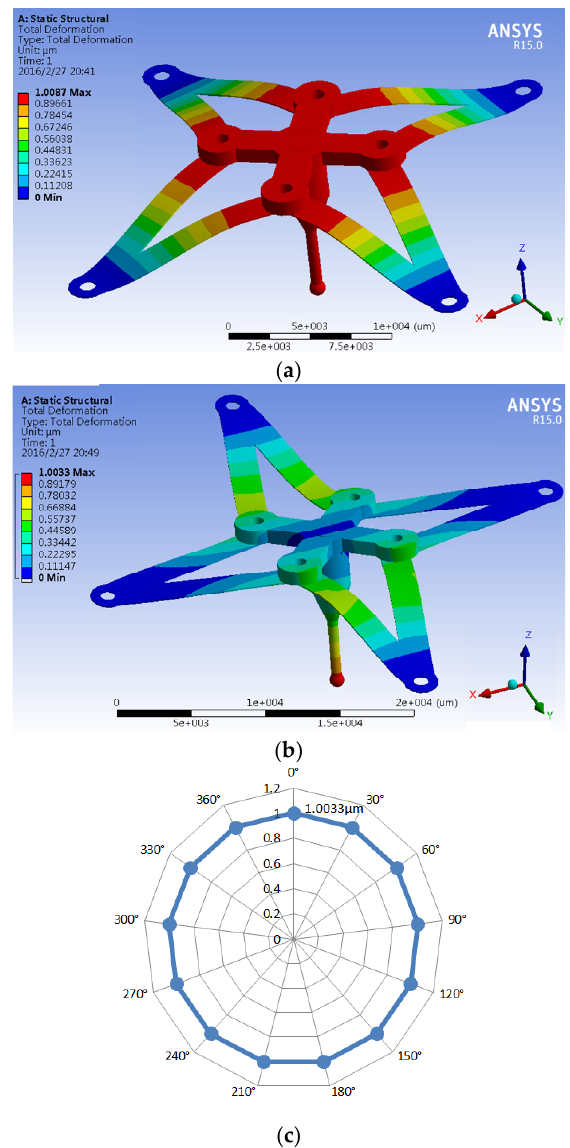
Figure 6. The tip ′ s displacements when being touched by 1 mN force. ( a ) Touched in Z direction; ( b ) touched in Y direction and ( c ) touched with a different angle in XY plane.